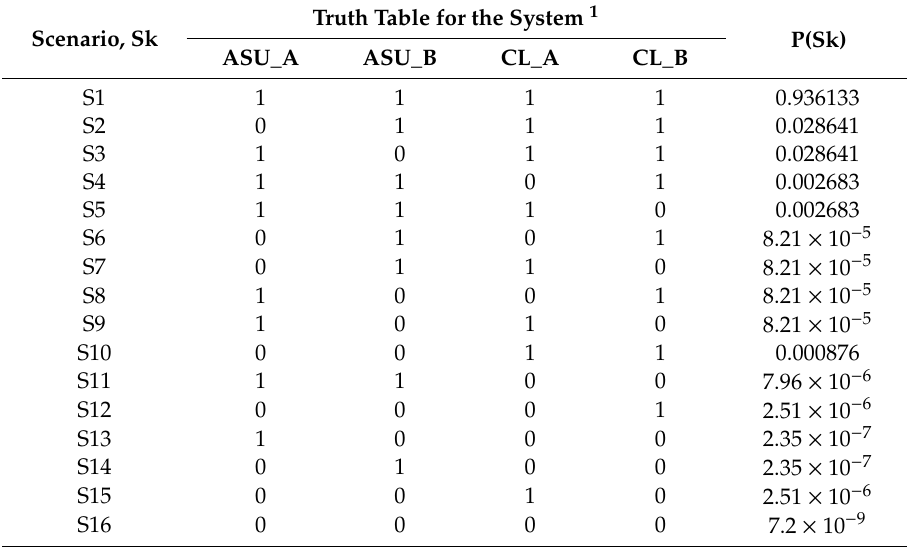
Table 3. Probability of possible scenarios for modeled activated sludge process. Truth Table for the System Scenario, Sk